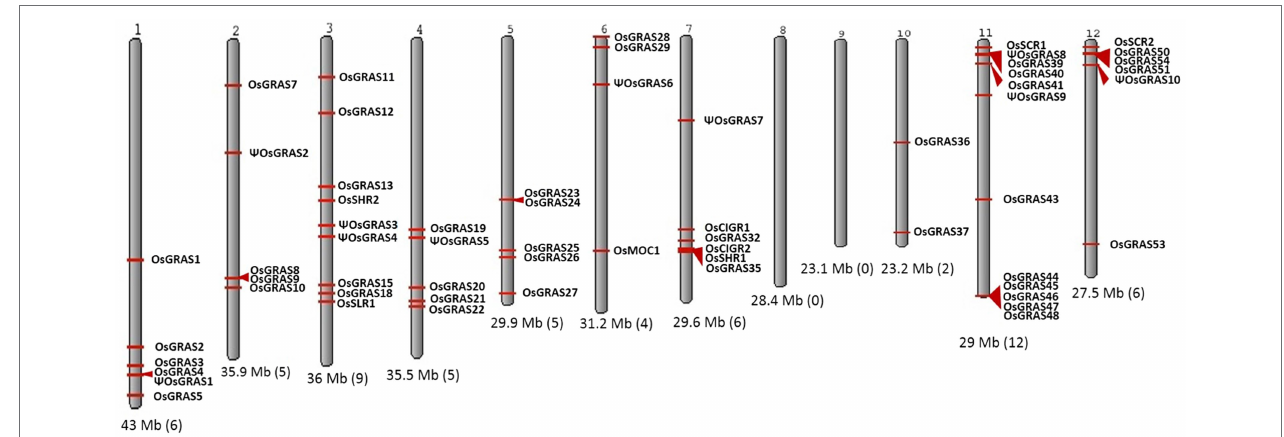
FIGURE 1 | Chromosomal distribution of GRAS genes in rice. Karyotypic representation of rice chromosomes obtained from NCBI Genome Decoration Page. Rice genome carries 60 GRAS genes, which are represented in the figure with red arrows indicating the position of each gene. The size of each chromosome and the number of genes present are provided below each chromosome in